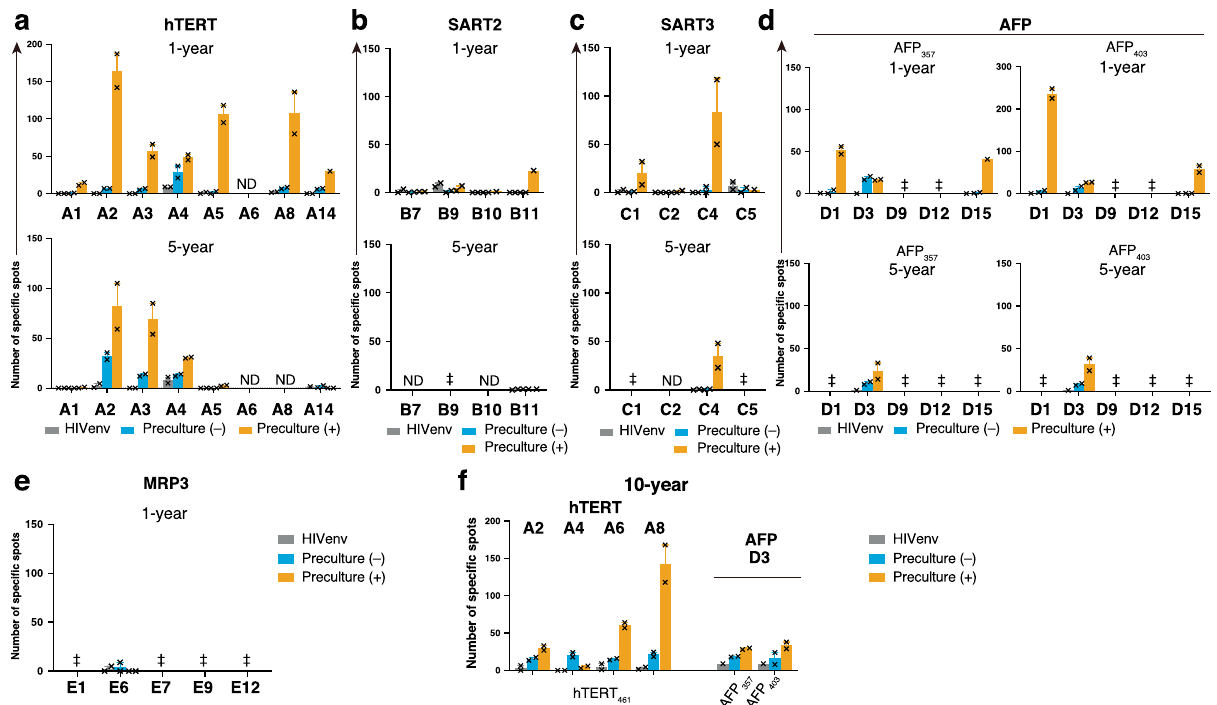
Fig. 3 Persistent peptide-speci fi c immune responses after vaccination. PBMCs of CTL( + ) patients were collected at each timepoint and tested by the IFN- γ ELISpot assay. The experiments were performed in duplicate and mean numbers of speci fi c spots are displayed in bar graphs per patient with experimental values (cross marks). The CTL( + ) cases among the hTERT participants were examined. The upper graph presents the 1-year result and the bottom graph shows the 5-year result. ND, not done because of unavailability of patient PBMC samples for a reason other than patient death. error bar, + s.e.m. a CTL( + ) cases of the SART2 peptide vaccine study are also shown. ‡ PBMCs were unavailable because of patient death. ND, not done. bar, mean number of spots; error bar, + s.e.m. b Four patients with positive CTL induction in the SART3 trial were. ‡ , PBMCs were unavailable because of patient death; ND, not done; bar, mean number of spots; error bar, + s.e.m. c For CTL( + ) participants in the AFP trial, ELISpot assays using AFP357 and AFP403 were separately carried out and shown in graphs. ‡ PBMCs were unavailable because of patient death. bar, mean number of spots; error bar, + s.e.m. d ELISpot results of CTL( + ) patients from the MRP3 study are shown. Because no patient survived for 5 years, only one graph is shown. Because of the low cell number, a preculture experiment was not performed using E6 PBMCs. ‡ PBMCs were unavailable because of patient death. ND, not done. bar, mean number of spots; error bar, + s.e.m. e At the 10-year timepoint after vaccination, there were only fi ve patients who had survived: four patients in the hTERT cohort and one patient in the AFP study. These were all CTL( + ) cases. Immune responses against the peptides are shown in a graph. bar, mean number of spots; error bar, + s.e.m. f Source data are provided as a Source Data fi